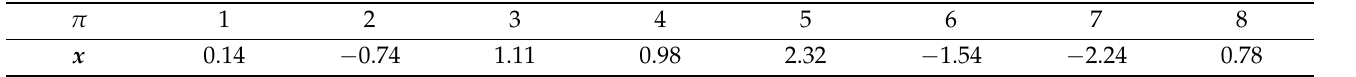
Table 2. Illustrative example of encoded solution x and permutation solution π